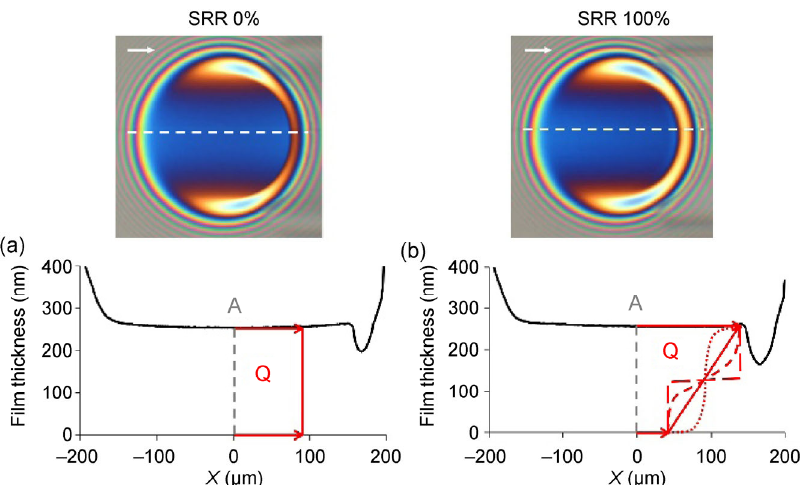
Fig. 2 Interferograms and centerline film thickness profiles with illustrated speed profile under (a) pure rolling; (b)